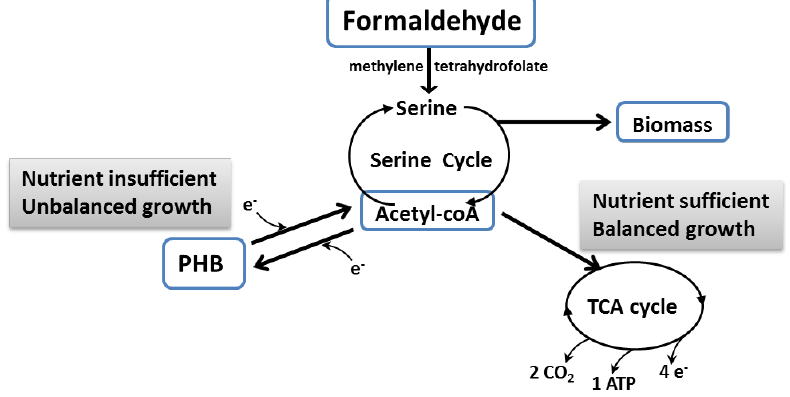
Figure 3. Schematic indicating carbon flow from the serine cycle with regard to balanced